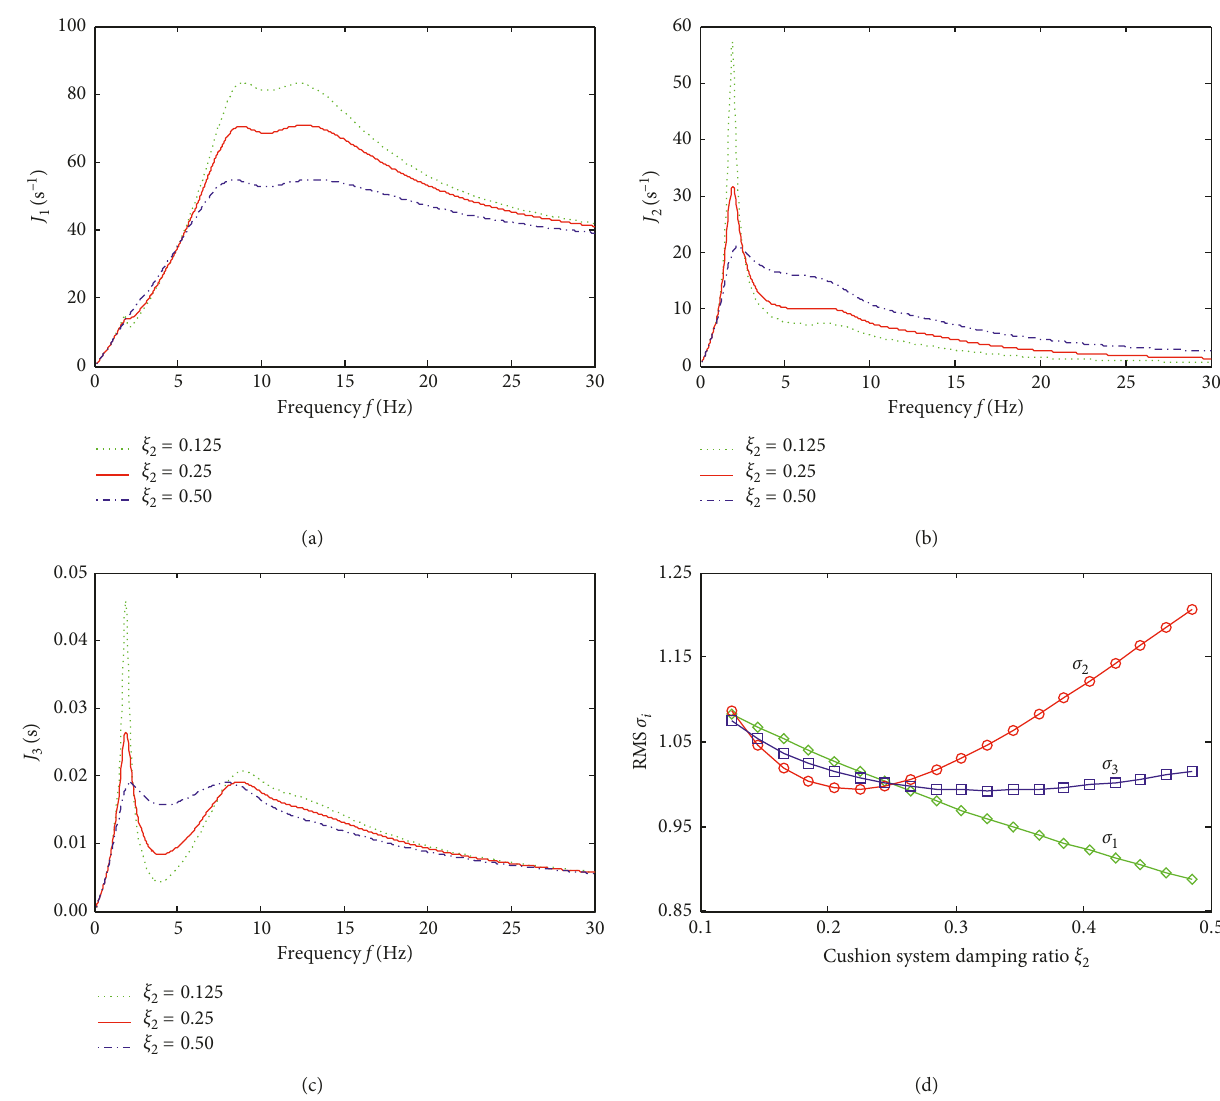
Figure 6: Influence of ξ on € z , € z , and f : (a) the amplitude frequency characteristics J 2 1 2 d at different values of ξ ; (c) the amplitude frequency characteristics J frequency characteristics J 2 2 σ , and σ versus ξ 2 3 2